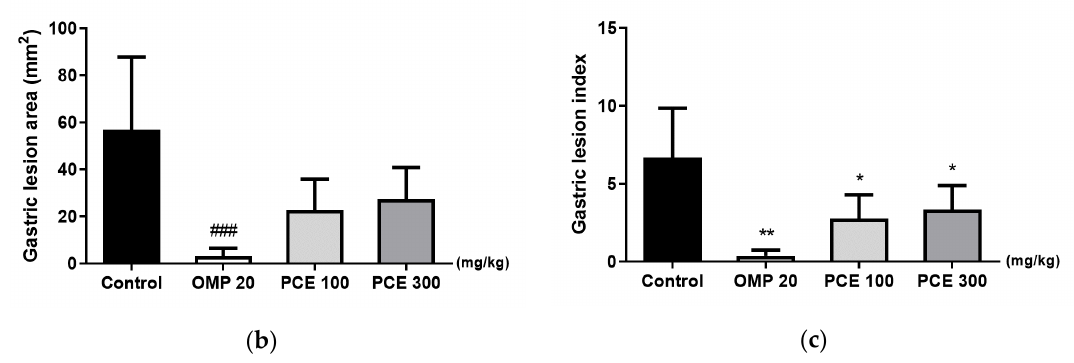
Figure 3. Gastroprotective effects of PCE on indomethacin-induced ulcer in the gastric mucosa of SD rats. ( a ) Representative macroscopic images of stomachs from each group. Rats were pre-treated orally with distilled water (control), OMP 20 mg/kg, PCE 100 mg/kg, or PCE 300 mg/kg 30 min prior to indomethacin administration. Measurement of gastric lesion area ( b ) and gastric lesion index ( c ). Values are expressed as mean ± standard deviation. n = 6–8 per group. * p < 0.05, ** p < 0.01 vs. control by Welch’s analysis of variance (ANOVA) with Dunnett’s T3 multiple comparisons test, ### p < 0.001 vs. control by Kruskal–Wallis test with Dunn’s multiple comparisons test. OMP, omeprazole; PCE, P.